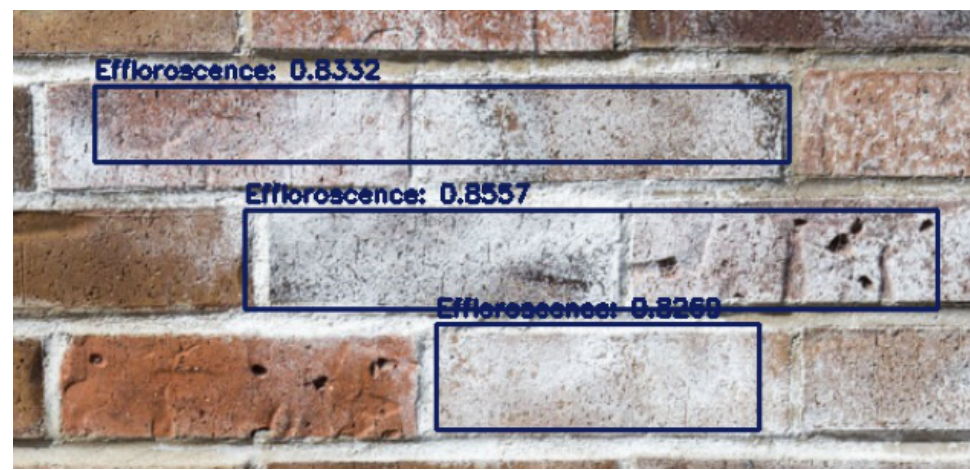
Figure 1. Example of output from the Build-Sense model – model draw bounding boxes around damaged area alongside with its level of confidence